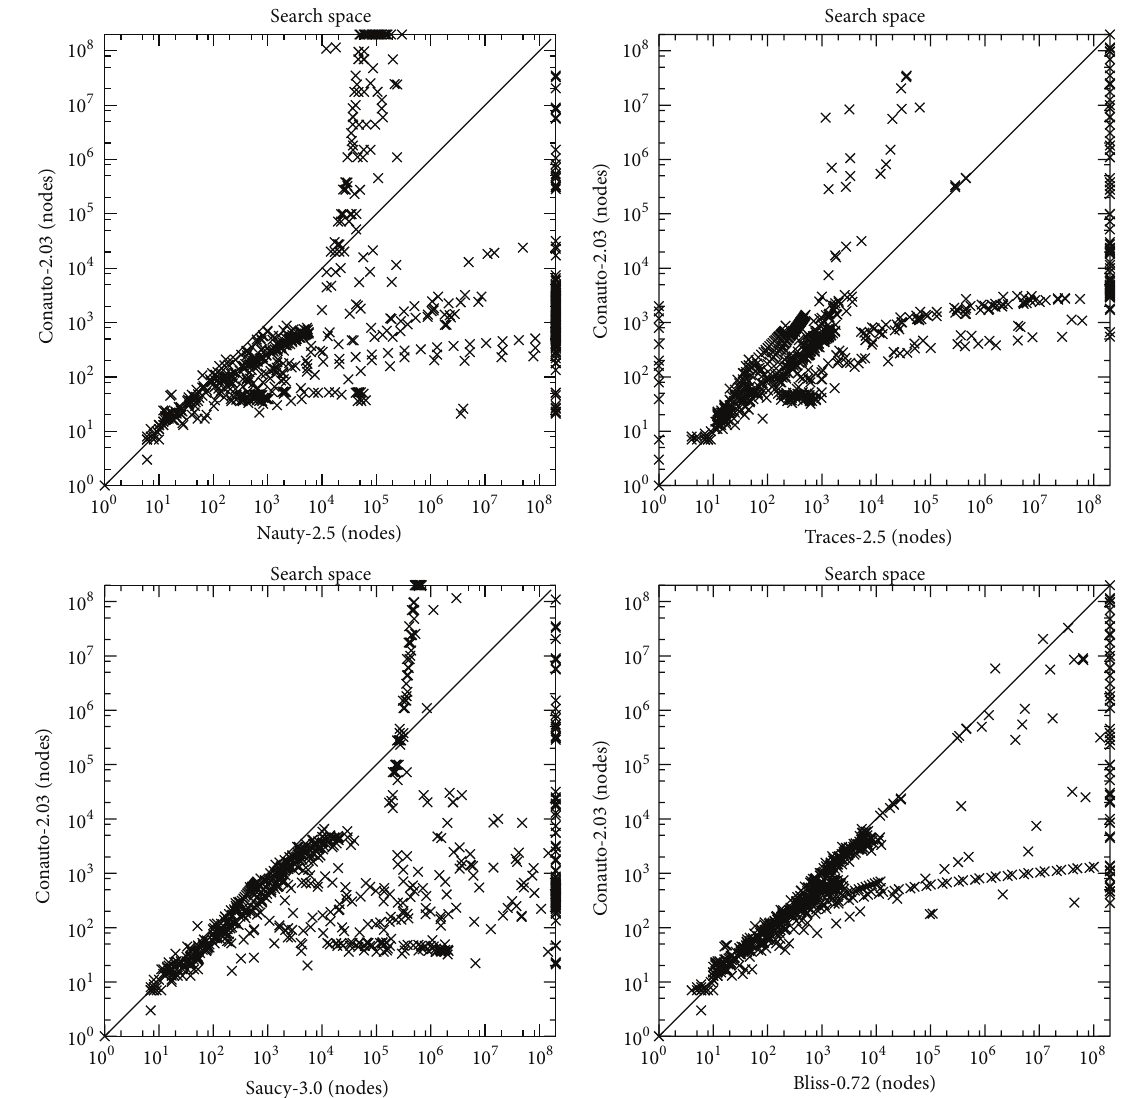
Figure 7: Comparison of the search-space of conauto-2.03 against nauty-2.5, Traces-2.5, saucy-3.0 and